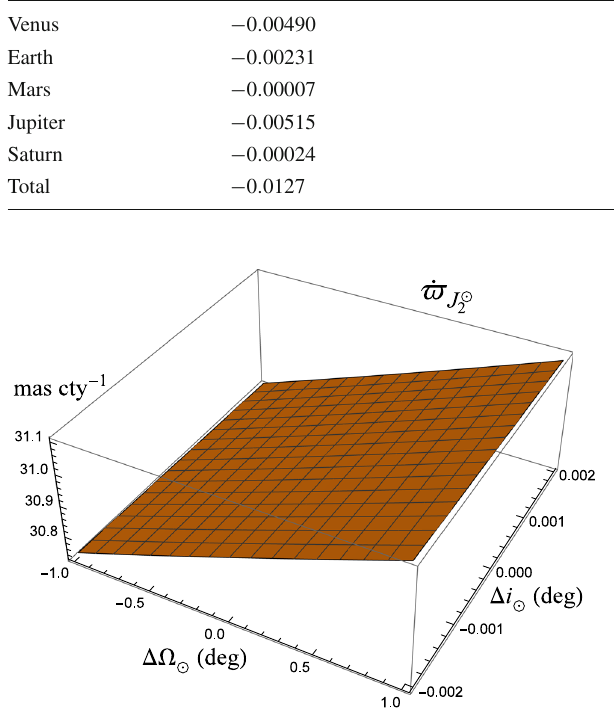
((cid:8)(cid:6) (cid:3) , (cid:8) i (cid:3) ) , with the Sun’s spin axis ˆ S (cid:3) param- J (cid:3) 2